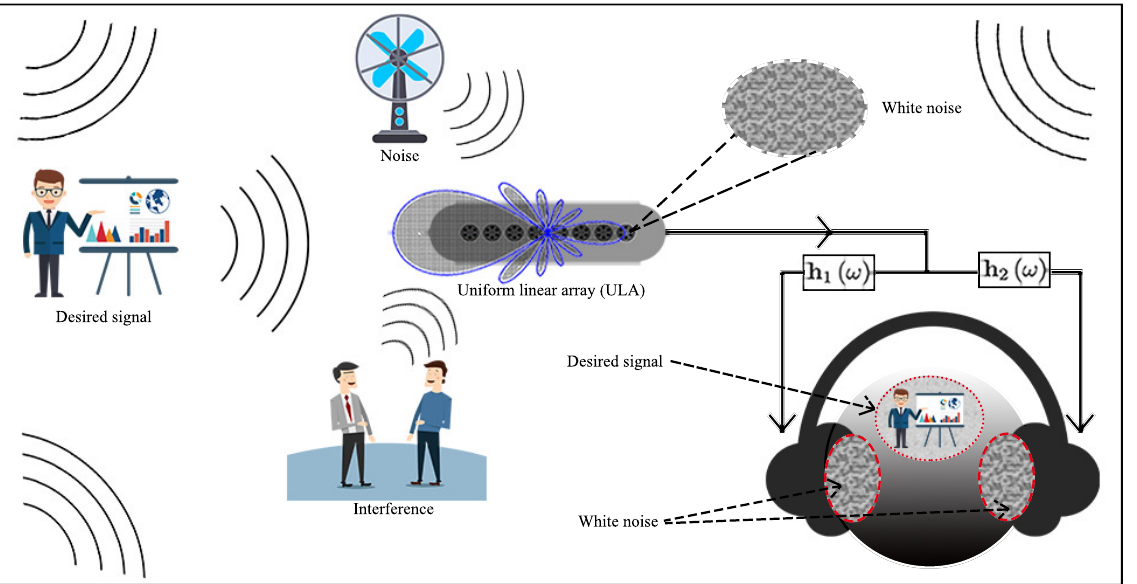
Figure 2. Illustration of the proposed binaural superdirective beamformer, which suppresses directional acoustic interference and noise and meanwhile separates the desired signal and the white noise into different